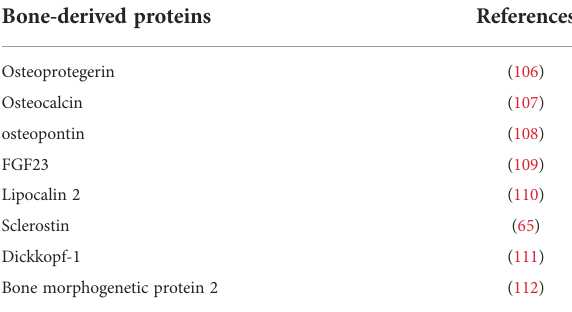
TABLE 1 Some bone-derived hormones as currently de fi ned. Bone-derived